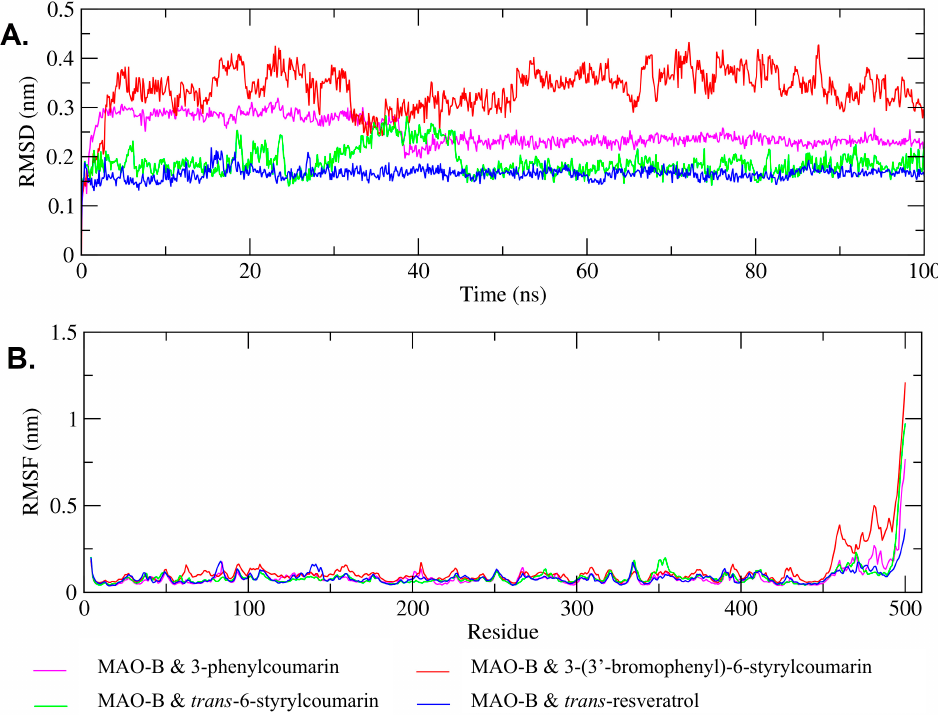
Figure 9. Trajectory analysis of the MD simulation of complexes of MAO-B with 3-phenylcoumarin, 3-(3 ′ -bromophenyl)-6-methylcoumarin, trans -6-styrylcoumarin and trans -resveratrol. ( A ) Plots of root mean square deviation (RMSD), and ( B ) root mean square fluctuation (RMSF) over 100 ns of protein–ligand complexes.